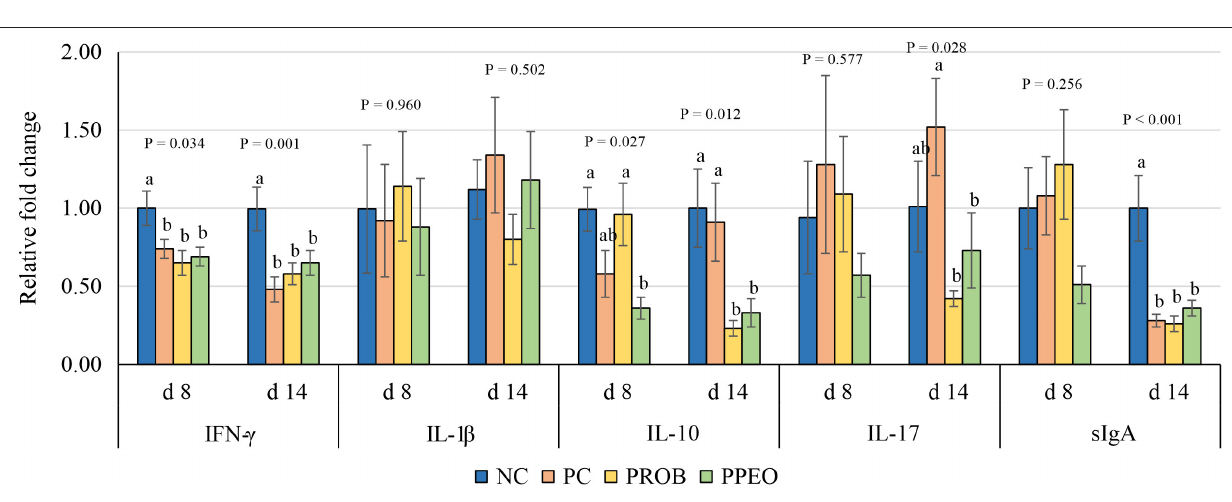
FIGURE 2 | Relative mRNA abundance of interferon (IFN)- È , interleukin (IL)-1 β , IL-10, IL-17 and secretory immunoglobulin (sIg)A in the jejunum of broiler chickens on day (d) 8 and 14. Birds reared under a naturally occurring necrotic enteritis challenge model. Treatments include: NC (negative control): corn-soybean meal basal diet; PC (positive control): NC + 20g virginiamycin (453g Stafac ® 20)/ton diet; PROB (Probiotic): NC + B. licheniformis spores at the level of 227 g/ton diet; PPEO (probiotic/prebiotic/essential oil supplement): NC + 453 g/ton of a supplement containing B. licheniformis spores, mannan-oligosaccharides, β -glucans (1,3 and 1,6), capsaicin, and curcuma. Values are represented as a n -fold difference relative to the calibrator (NC). Results are given as means ( n = 8) for each treatment. Error bars indicate standard errors. For each gene and sampling day, columns with different letters are significantly different ( P <